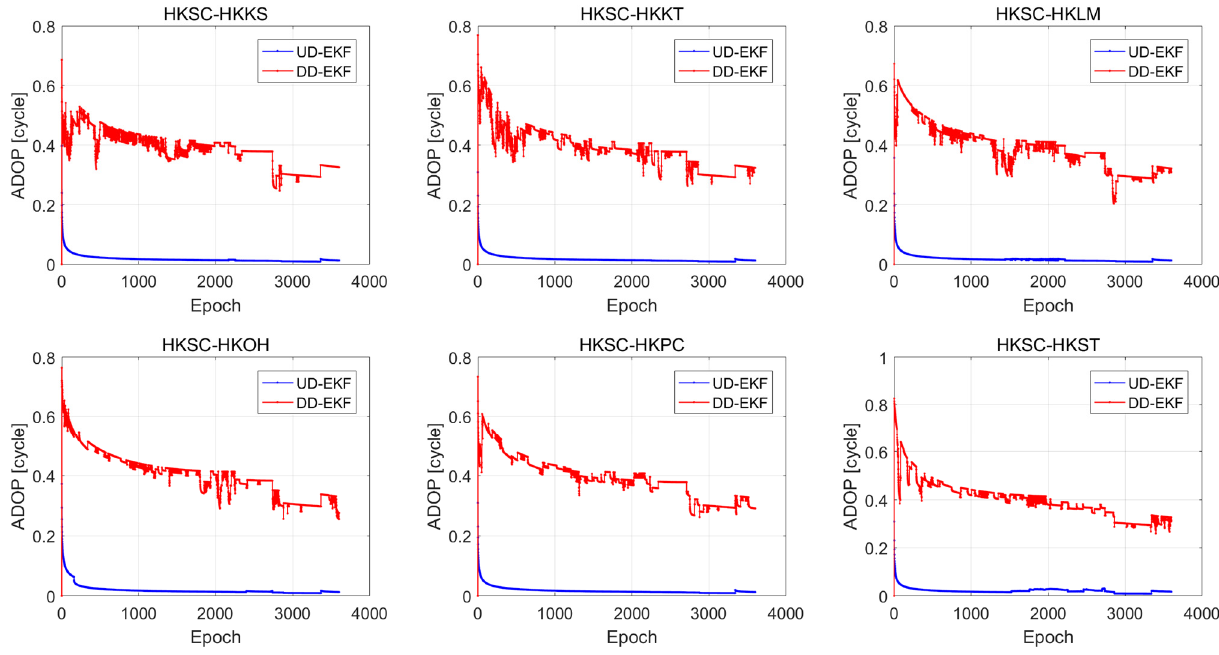
Figure 8. ADOP of UD-KF and DD-KF.